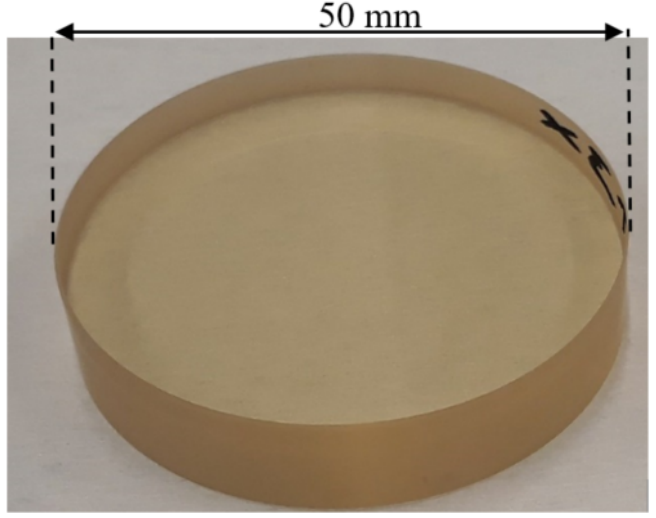
Figure 8. A photograph of the manufactured aspherical artefacts with additional steps slong the normal direction (TIMM-1).